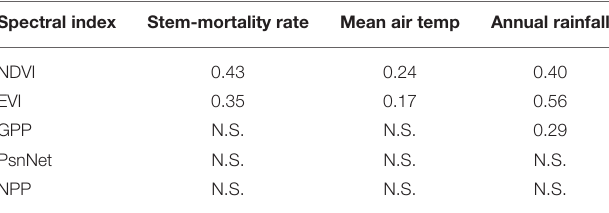
TABLE 2 | Coefficients of determination ( R 2 ) of the linear relationships between stem-mortality rates and spectral indices. N.S. indicates no significant relationship. Spectral